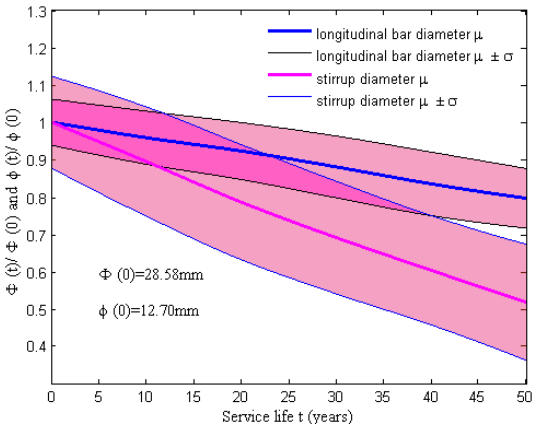
( ) ( ) 0 Φ = 28.58 mm and 0 φ